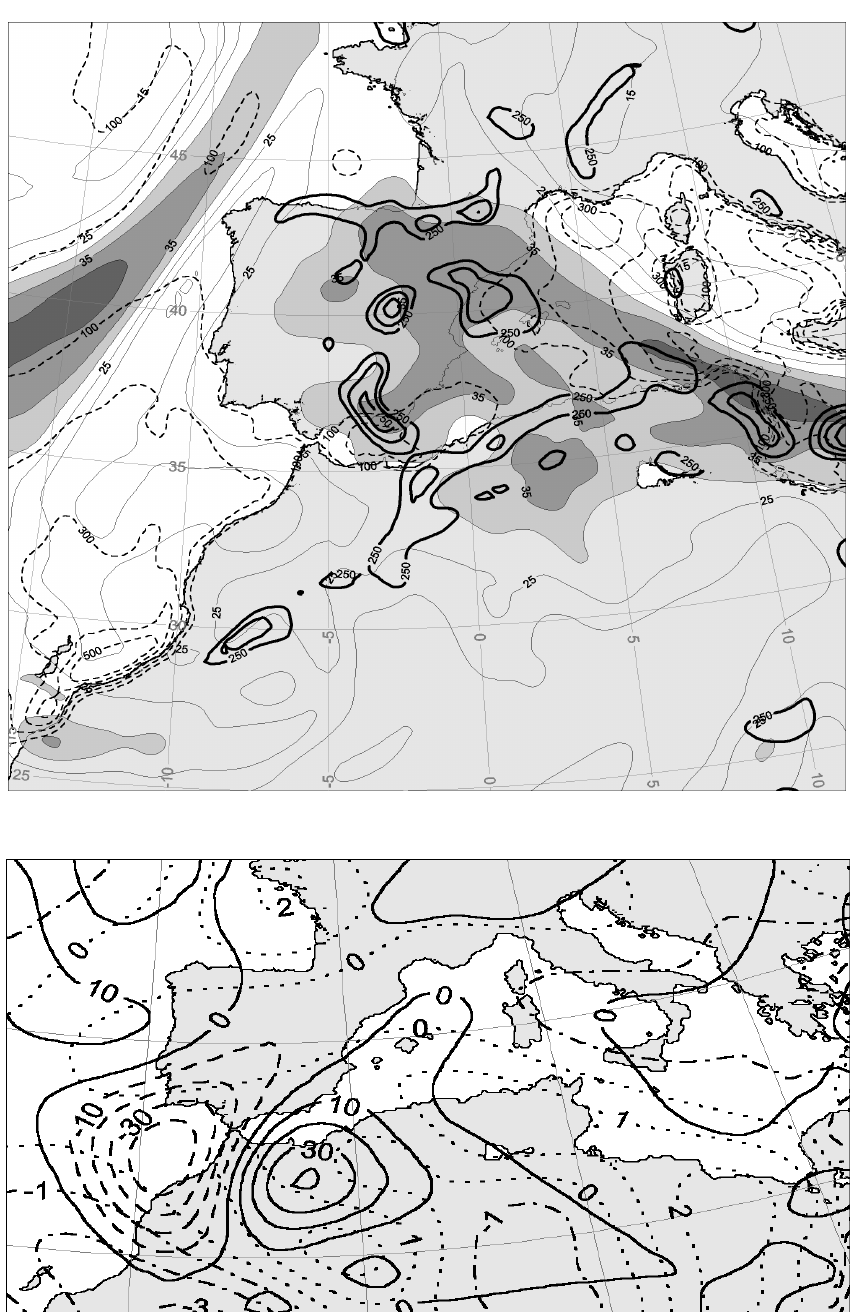
Fig. 13. Forcing term (-2 ∇ · Q ) of the quasi-geostrophic ω -equation (10 − 18 m/kgs) on 00:00UTC, 23 Oc- tober 2000 for domain 1 (zoom), at 300hPa (solid and dashed lines indicate positive and negative values, respec- tively), and 700 to 1000hPa averaged value (dotted and dash-dotted lines in- dicate positive and negative values, re- spectively). Note the different contour interval between upper and lower levels